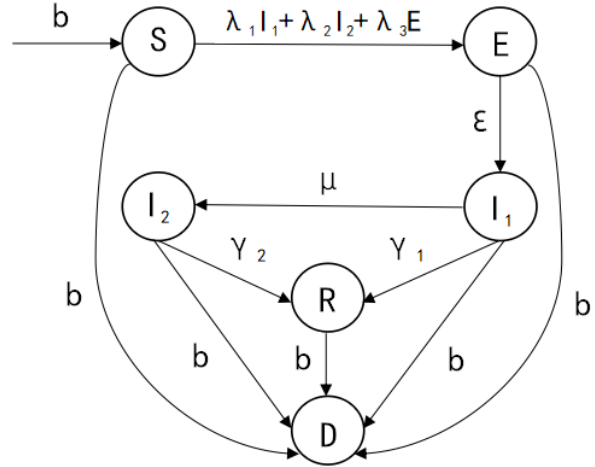
Figure 1. Flow chart of the infectious disease model. The number of nodes increases at rate b, they all belong to S nodes. Meanwhile, new E nodes are generated with λ 1 I 1 ( t ) S ( t ), λ 2 I 2 ( t ) S ( t ) and λ 3 E ( t ) S ( t ). The parameters λ 1 , λ 2 and λ 3 represent the transmission rate of I 1 , I 2 and E nodes, respectively. Because E nodes are mainly latent and the mutated virus is more infectious, λ 2 is greater than λ 1 and λ 1 is greater than λ 3 . E nodes are converted to I 1 nodes at rate ε , and I 1 nodes mutate to I 2 nodes at rate μ . Because I 1 and I 2 nodes are unable to work normally, they can be detected by the anti-virus program, and repaired at rate γ 1 and γ 2 , respectively. In addition, the five com- partments S , E , I 1 , I 2 and R have the same mortality b . All parameters are greater than 0. The parameters are summarized in Table 1. Table 1. The parameters of the model. Symbol